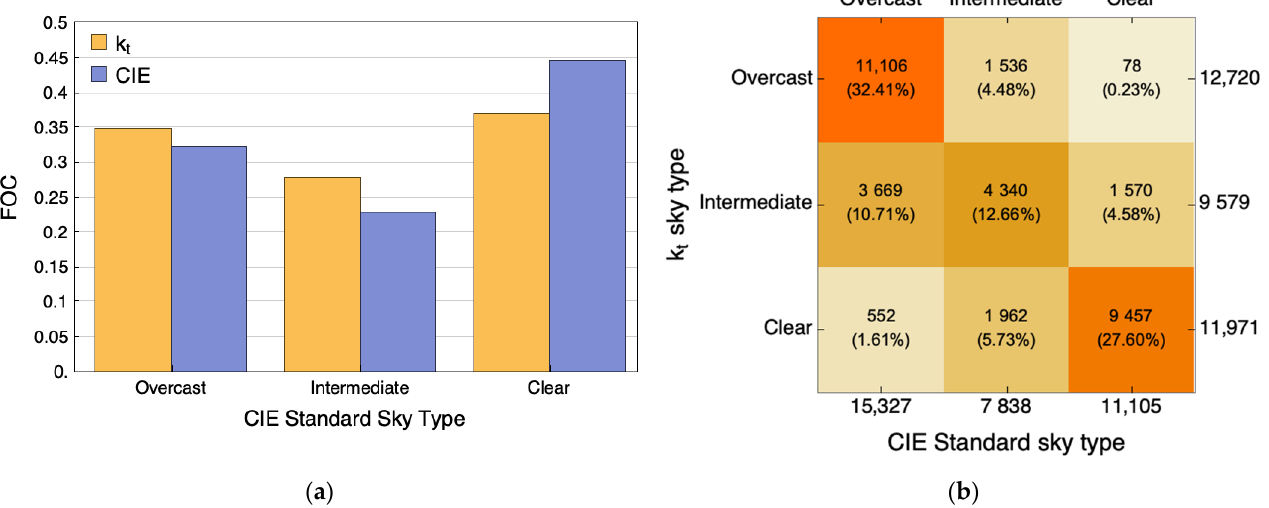
Figure 3. ( a ) Frequency of occurrence (FOC) of the CIE and 𝑘 (cid:3047) sky classifications in Burgos (Spain) from 14 September 2020 to 6 June 2022; and ( b ) confusion matrix showing the coincidences in the classifications obtained according to both criteria.